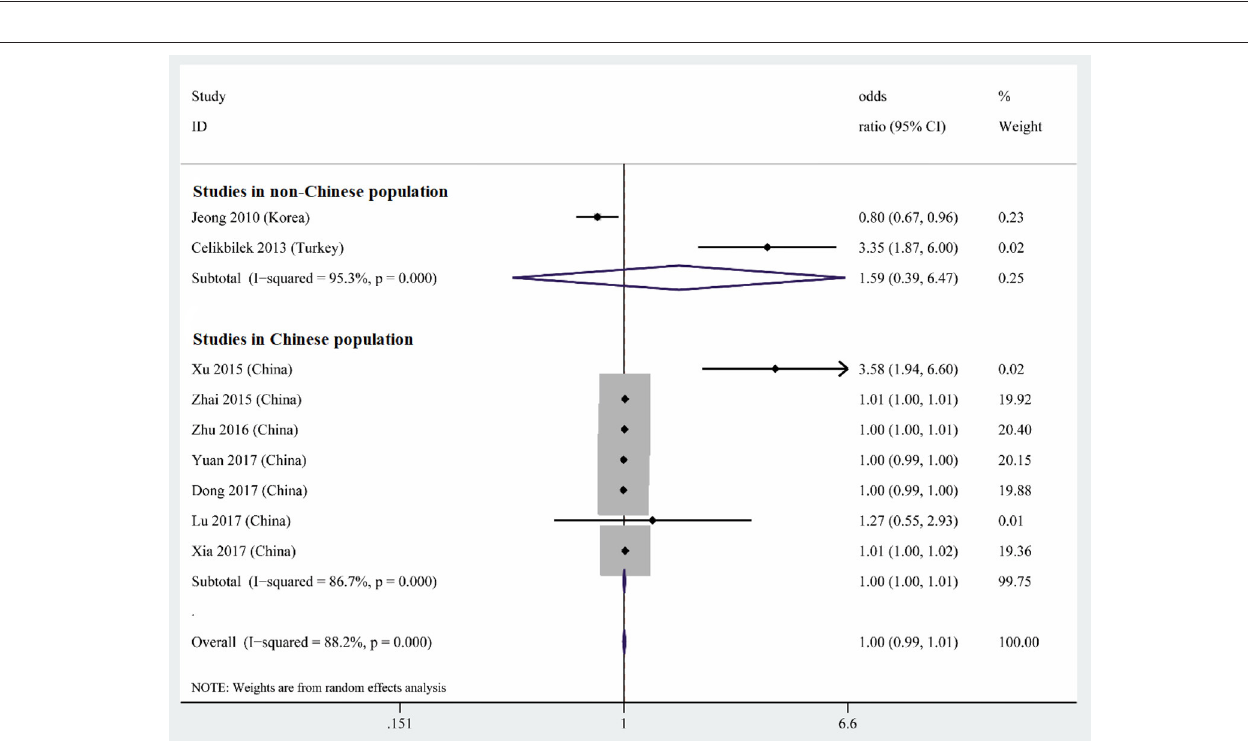
FIGURE 5 | Forest plot of serum uric acid level as an independent risk factor for BPPV across all studies, in the subset of studies conducted within China or in the subset conducted outside China. The x-axis shows the 95% confidence interval. of damaging reactive oxygen species (ROS). Through a similar acid levels can trigger inflammation of the gelatinous matrix to inflammatory mechanism, elevated serum uric acid levels may which otoconia are connected (33, 34); uric acid can promote trigger production of ROS that damage the vasculature (35, 36), the release of inflammatory mediators that induce production